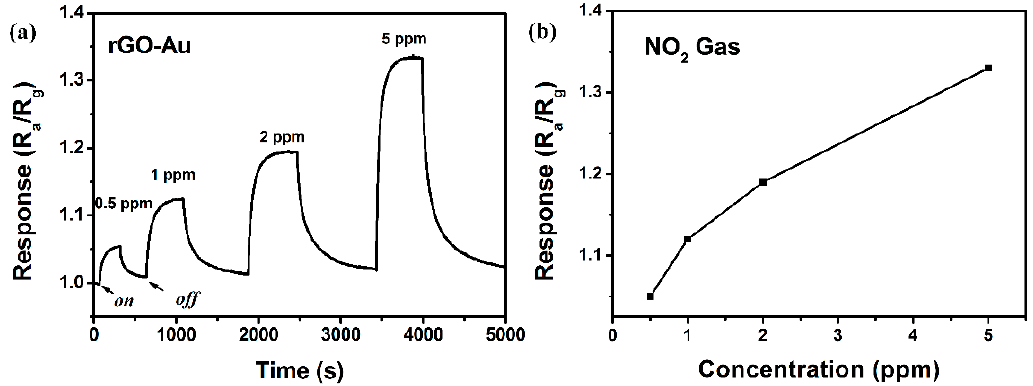
Figure 7. ( a ) Dynamic NO 2 sensing transients curve of the rGO/Au-based sensor to 0.5–5 ppm NO 2 at 50 °C; ( b ) The responses of the rGO/Au based sensor to 0.5–5 ppm NO 2 at 50 °C.